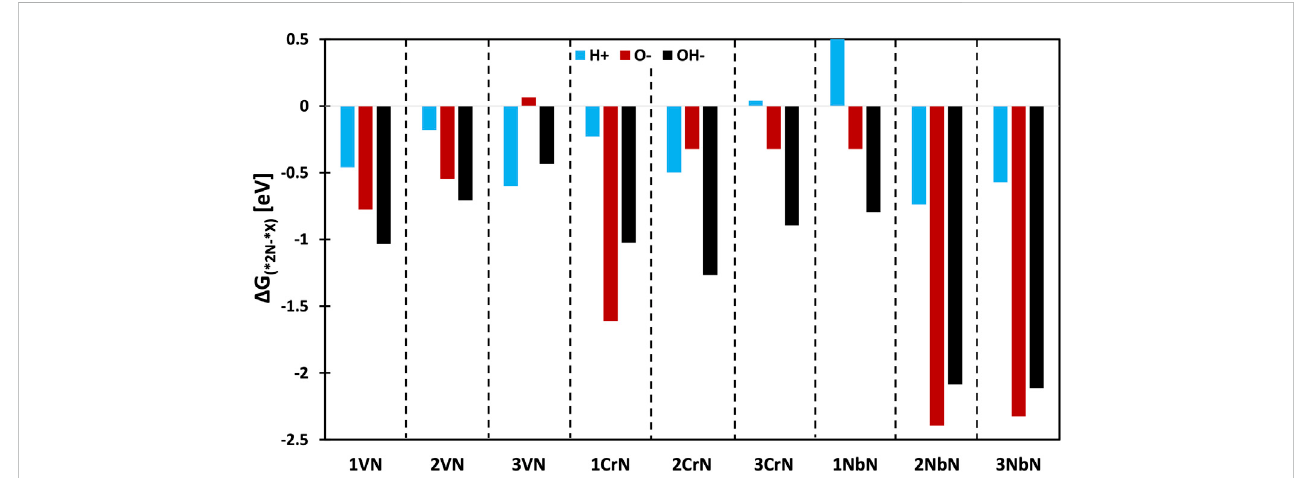
The stability against poisoning under electrochemical conditions, the values are obtained at the onset potential needed for initiation of